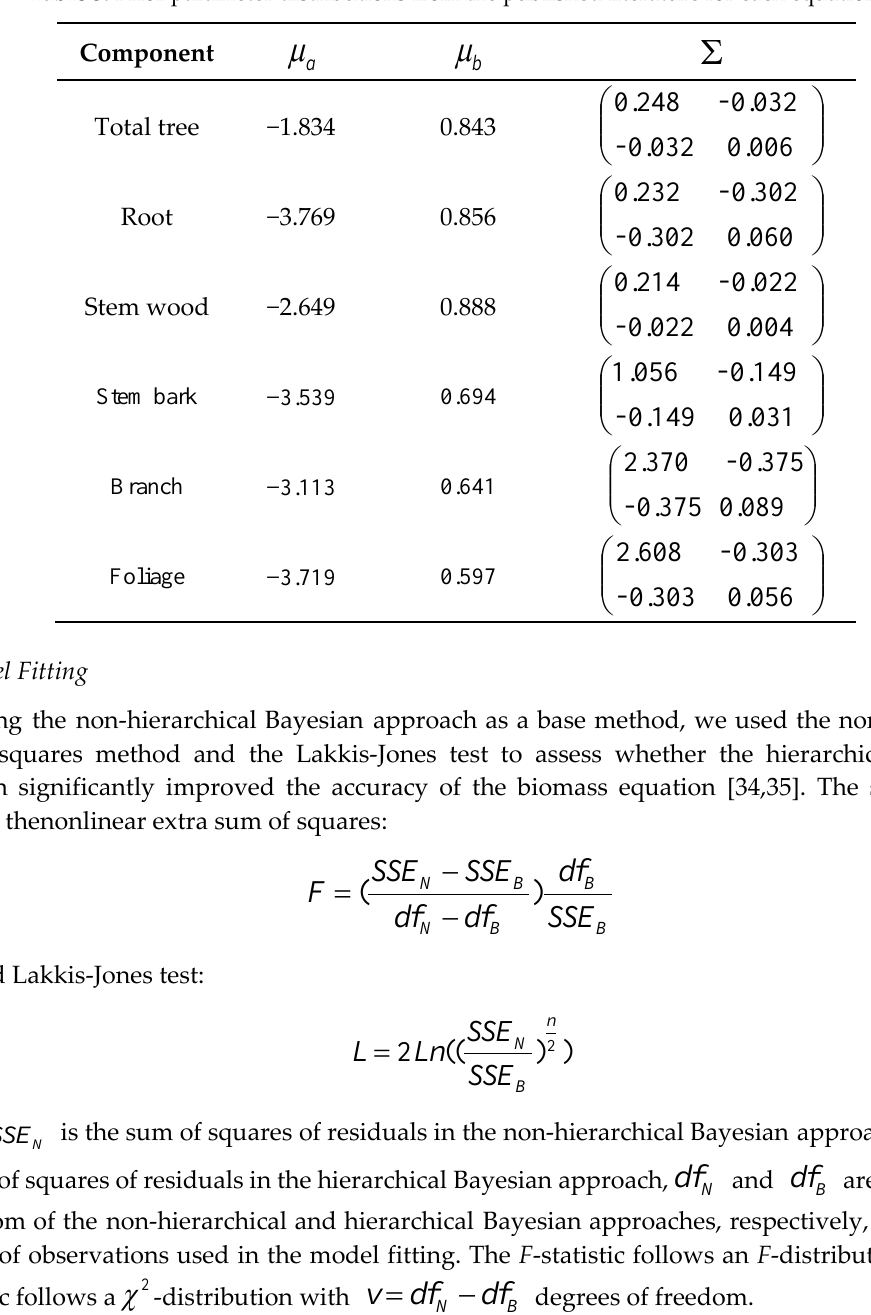
Table 3. Prior parameter distributions from the published literature for each